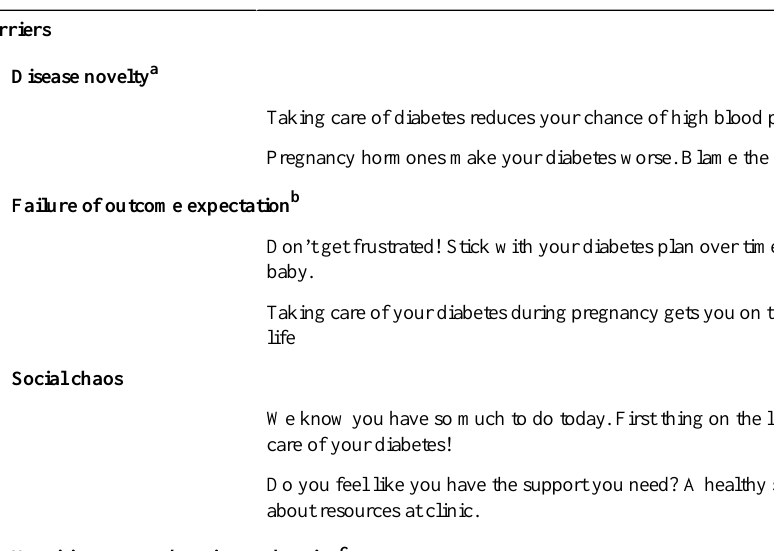
Example text messagesBarrier or facilitator